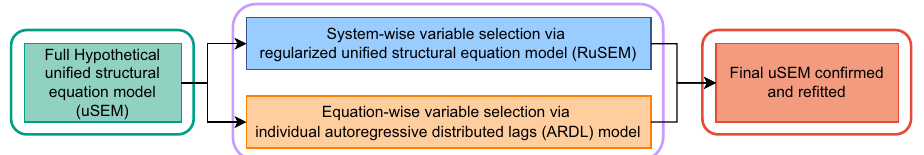
Figure 1. Flow chart of unified structural equation model (uSEM) pathway identification process using two variable selection methods, the system-wise regularized unified structural equation modeling (RuSEM) approach, and the equation-wise stepwise variable selection method using each individual uSEM equation, which is also an autoregressive distributed lags (ARDL) model. The fully hypothesized uSEM model and